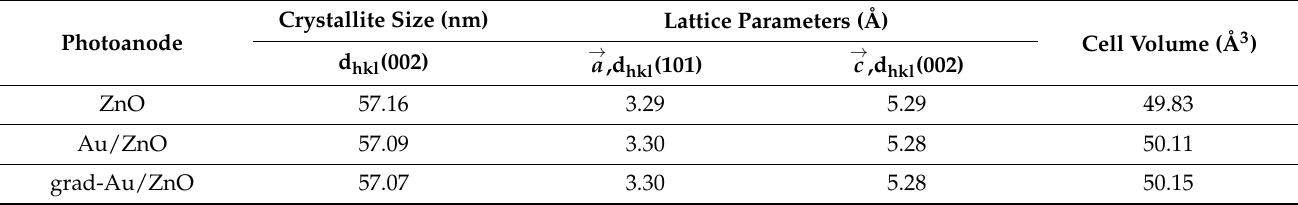
Table 1. Structural and properties of the